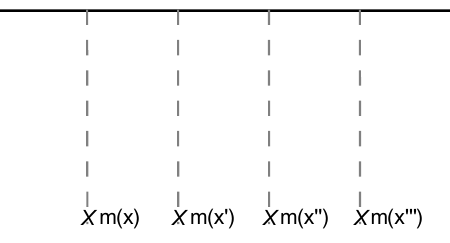
Figure 1 . The propagation of a particle (horizontal solid black line) in presence of field dependent p mass insertions, m ( x ) = λ/ 2 φ 0 ( x ) (vertical dashed